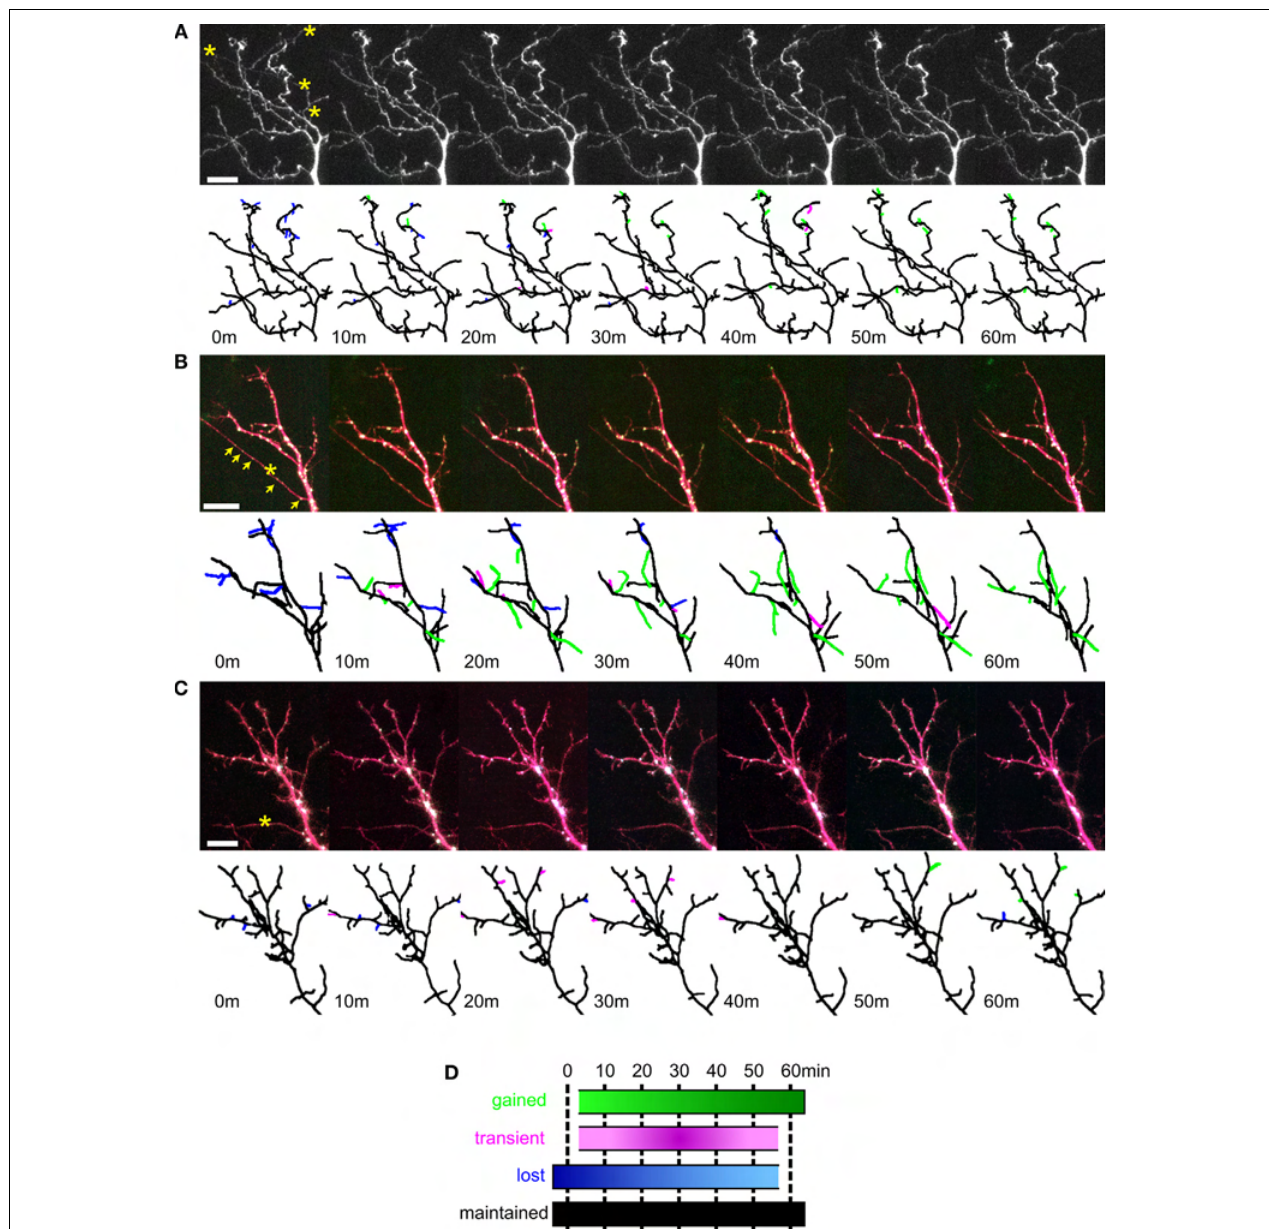
FIGURE 5 | Dynamic branch behaviors of tectal neurons expressing YFP, CPEB, and delCPEB. Example of dendrites from a control cell expressing YFP alone (A), full-length CPEB–CFP and YFP (B) and delCPEB–CFP and YFP (C) . Each cell was imaged seven times, once every 10 min. Below each photomicrograph is the projection of the 3D reconstruction of the dendritic arbor with the branches color coded to refl ect their behaviors (illustrated in D ) over the course of the 60 min. (B,C) CFP-labeled RNP granules appear as white puncta when colocalized with the YFP (in magenta). (D) Diagram